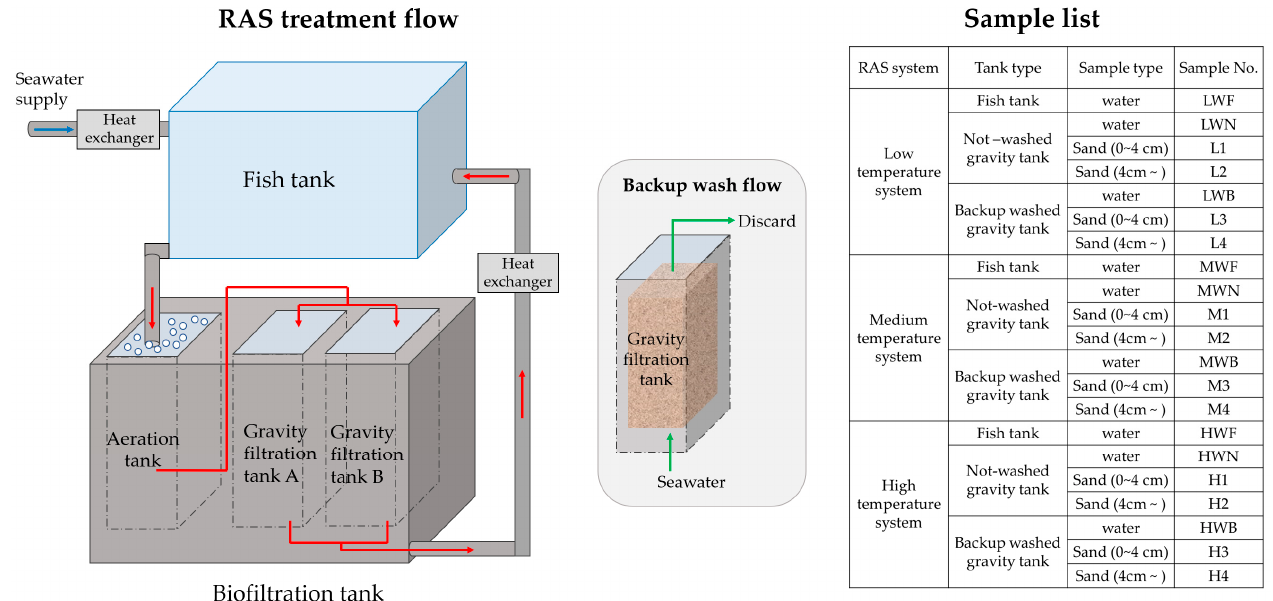
Figure 1. Schematic diagram of the aquarium RAS system. Sample type and its abbreviation name (samples No.) are shown in the sample list on the right.